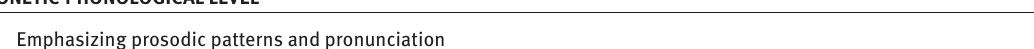
PHONETIC-PHONOLOGICAL